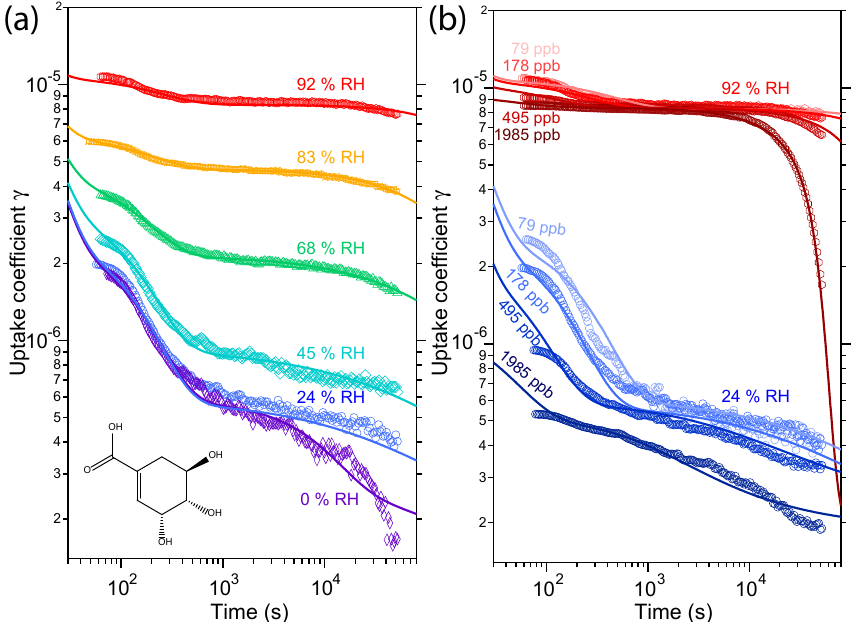
Figure 4. Observed (markers) and modelled (lines) uptake coefficients of ozone on a thin film of shikimic acid as a function of exposure time. (a) Uptake coefficients at 178ppb ozone gas-phase concentration [O 3 ] g at different relative humidities of 0, 24, 45, 68, 83, and 92%. The structural formula of shikimic acid is displayed in the bottom left corner. (b) Uptake coefficients at 24% RH (blue solid lines) and 92% RH (red solid lines) with different [O 3 ] g of 79, 178, 495, and 1985ppb. Reproduced from Berkemeier et al. (2016) with permission from the PCCP Owner Societies.